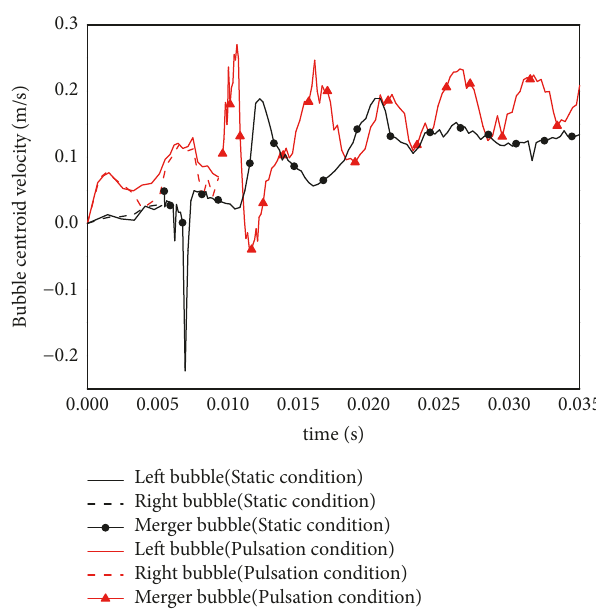
Figure 13: The change of bubble centroid velocity with time under two initial